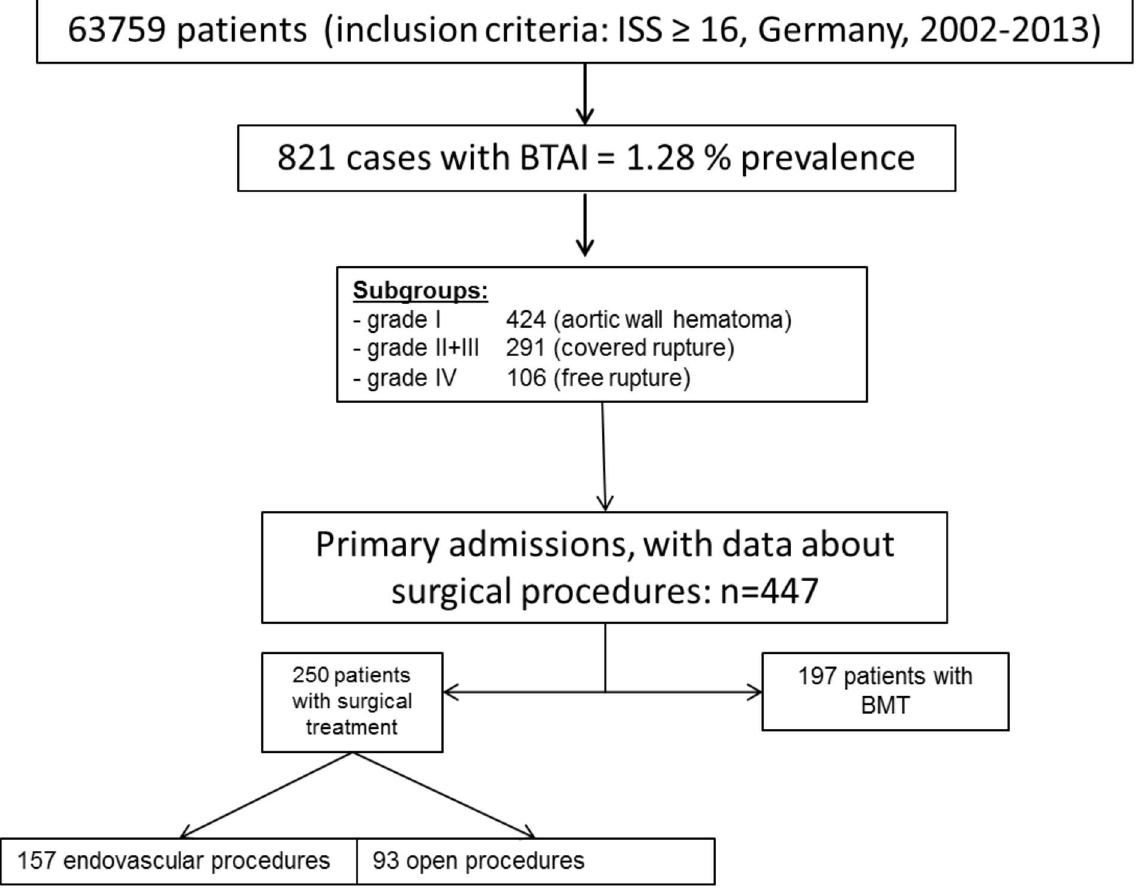
Fig 1. The structure of the patients’ selection based on the data delivered by the TraumaRegister. DGU ® from 2002 to 2013.